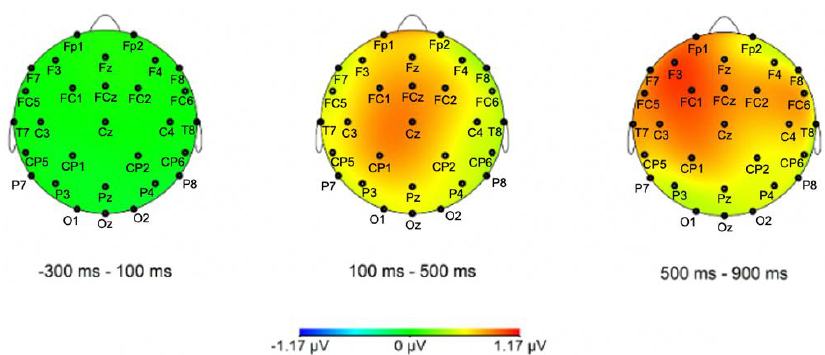
Figure 6. Topographical distribution maps of the difference wave for the adjective position-